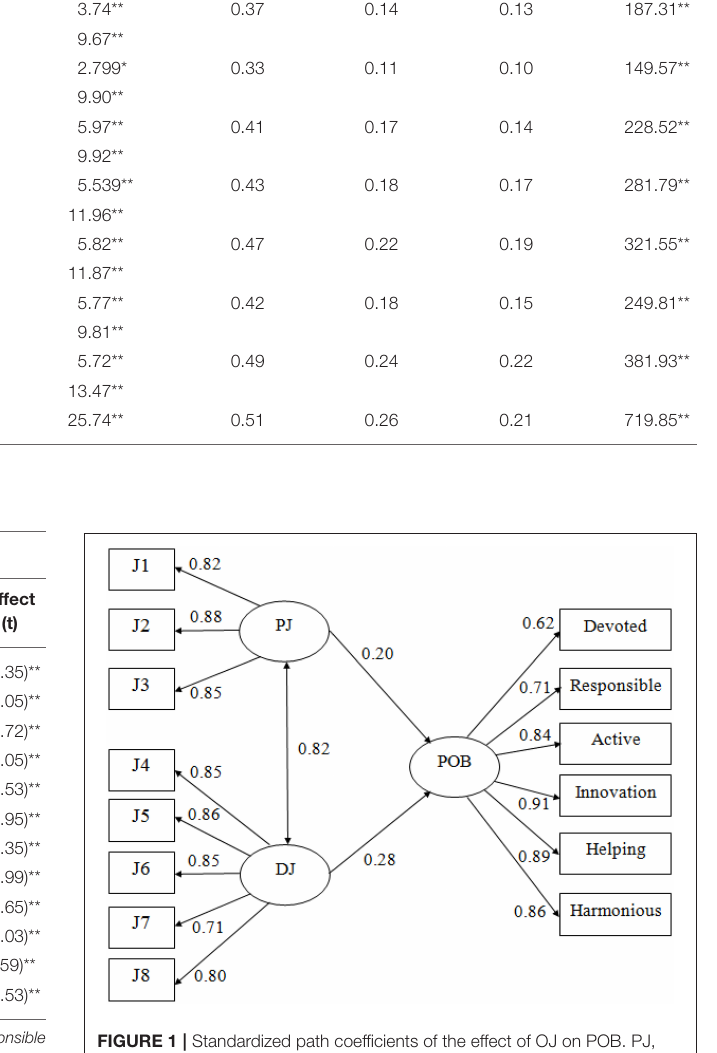
FIGURE 1 | Standardized path coefficients of the effect of OJ on POB. PJ, Procedural justice; DJ, Distributive justice; J1 ∼ J8, items of the scales of Organizational